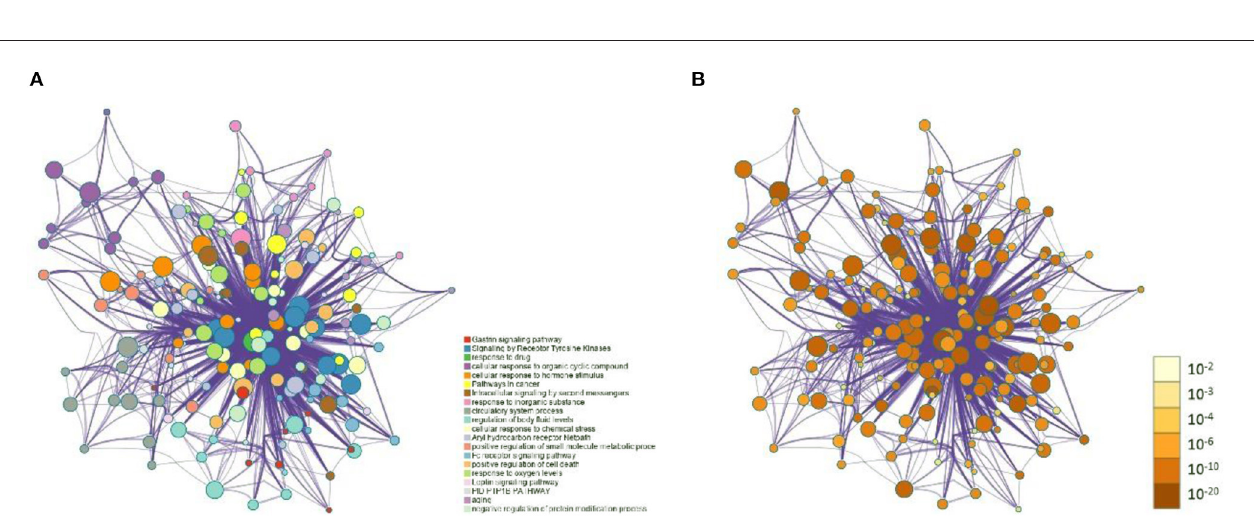
FIGURE 3 | Network of enriched terms: (A) Circles represent enrichment to cluster IDs, colored by cluster ID, where nodes that share the same cluster ID are typically close to each other. (B) Network graph constructed according to the degree of enrichment, the darker the color, the more genes are enriched into the pathway.